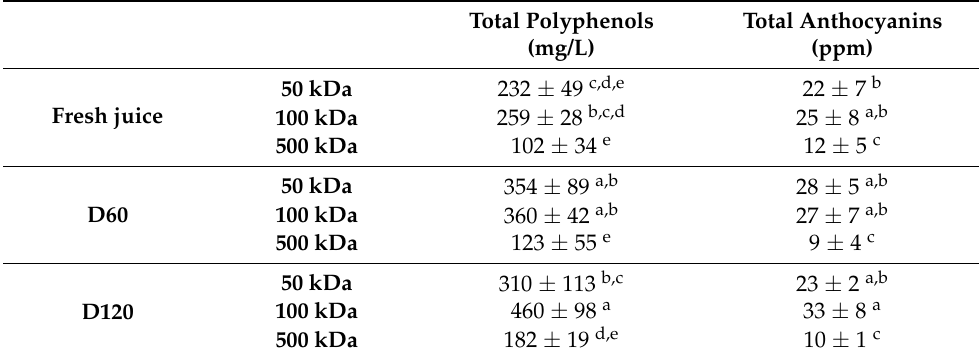
Table 4. Characterization of fouling material extracted from UF membrane surfaces after clarification of fresh and depectinized (D60 and D120) cranberry